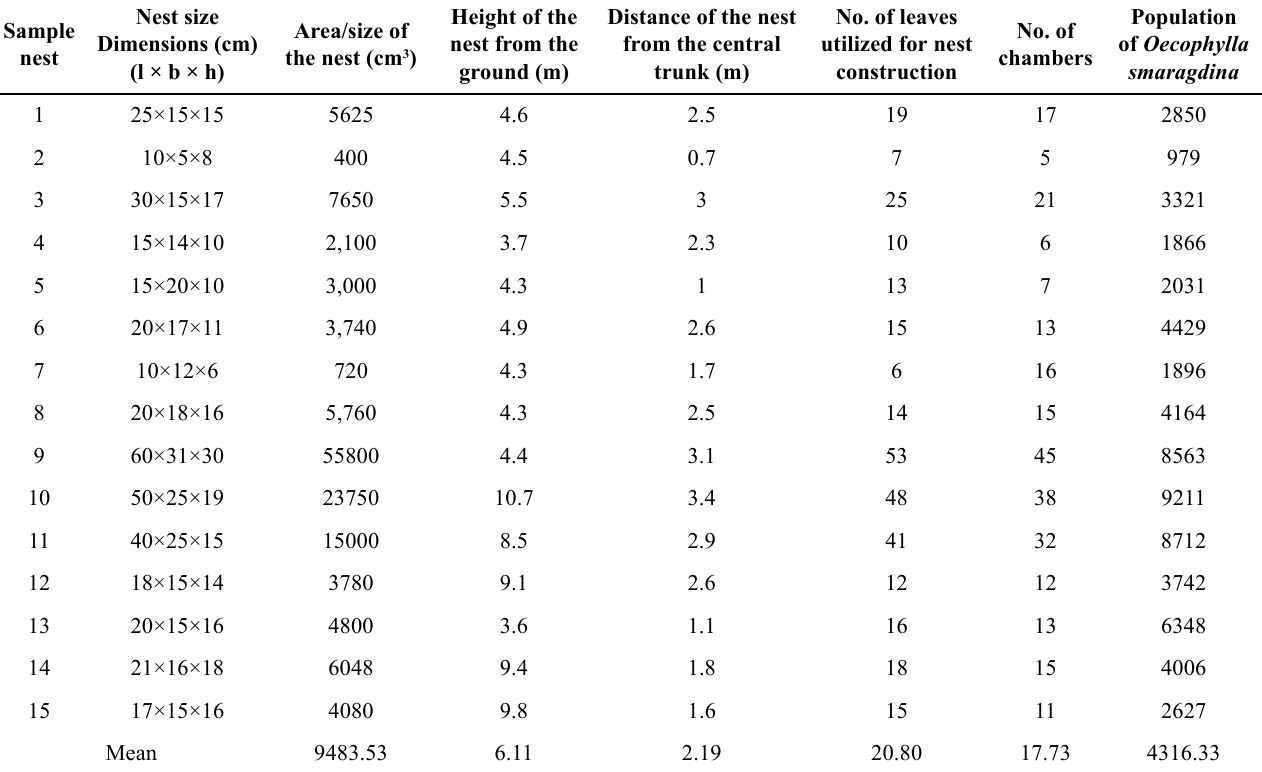
Table 1 . Demographic details of O. smaragdina nests on needlewood trees in Ri-Bhoi district of